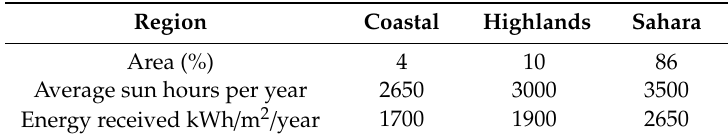
Figure 1. Horizontal Irradiation of Algeria [50]. Table 1. Radiation in Algeria